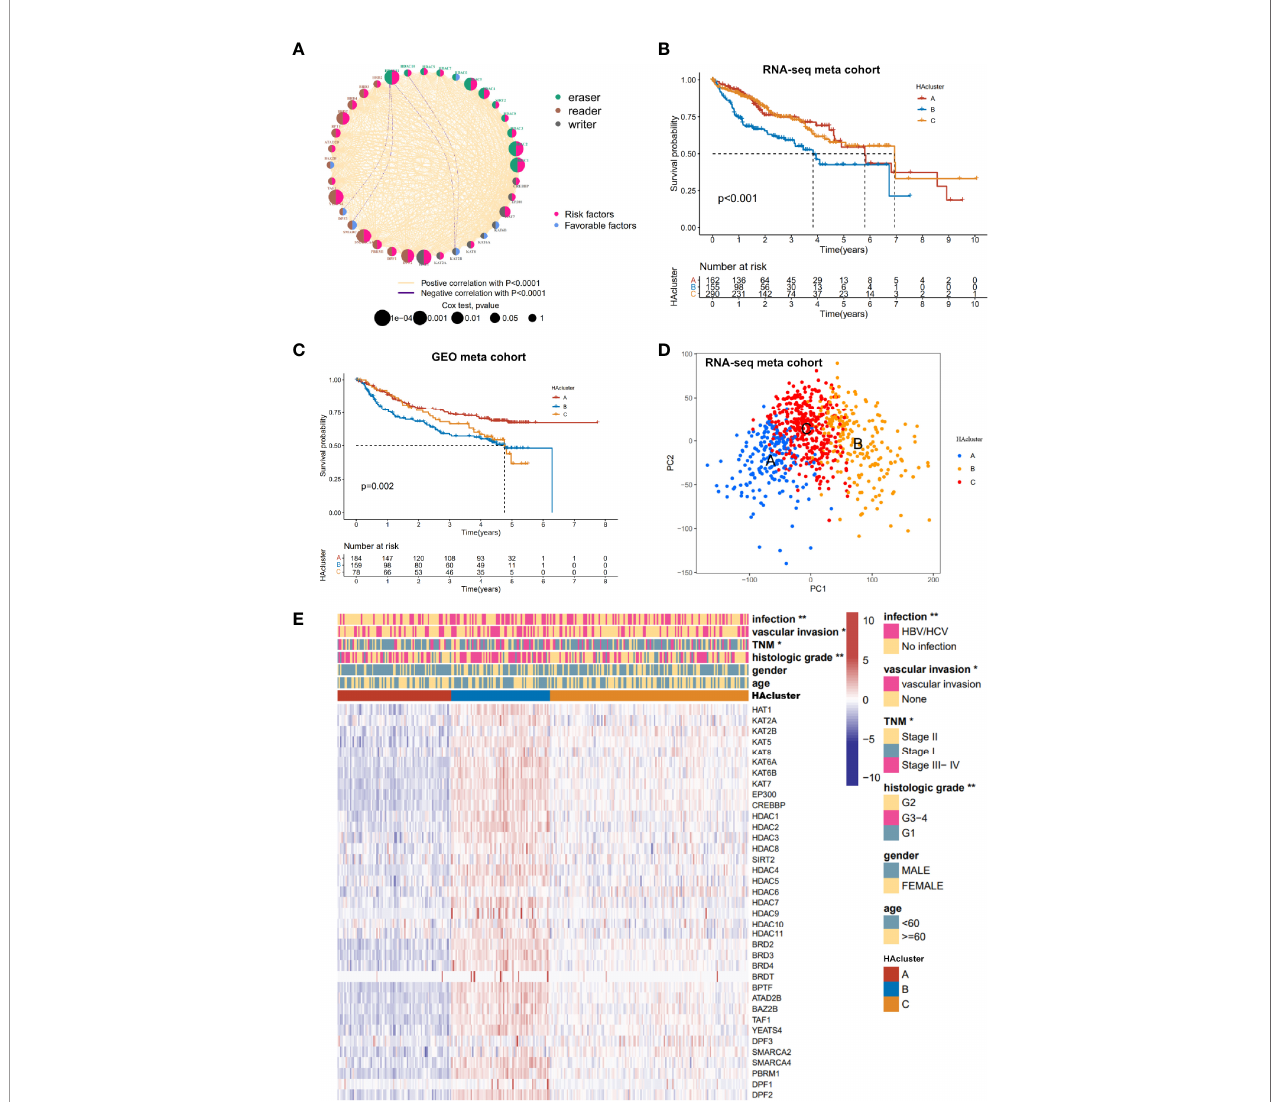
FIGURE 2 | Histone acetylation modi fi cation pattern and clinical characteristics of each pattern. (A) The interaction among histone acetylation regulators in liver cancer. The circle size describes the effect of each regulator on the prognosis and scale by P value. Favorable factors are shown with a pink semicircle on the right. Risk factors are shown with a blue semicircleon the right. Three histone modi fi cation types of the 36 histone acetylation regulators are depicted by different colored semicircle on the left. Readers: Indigo; writers: brown; erasers: gray. The red and blue lines represent positive and negative correlations, respectively ( P < 0.0001). (B) Survival analyses of three histone acetylation modi fi cation patterns based on 607 patients from the RNA-seq meta cohort (TCGA-LIHC, ICGC-LIRI). (C) Survival analyses of three histone acetylation modi fi cation patterns based on 421 patients from the GEO meta cohort (GSE14520, GSE76427, GSE116174). (D) Principal component analysis of the transcriptome pro fi les between three histone acetylation modi fi cation patterns, indicating a prominent difference on the transcriptome between different HAclusters (based on RNA-seq meta cohort). (E) Unsupervised clustering of the 36 histone acetylation modi fi cation regulators in the TCGA-LIHC cohort. The HAcluster, viral infection, vascular invasion, TNM stage, histology grade, age, and gender were used as sample annotations. Red represents high expression, and blue represents low expression. Comparison of clinical characteristics proportion analysis between three HAclusters was evaluated by Chi-square test (* P < 0.05, ** P <